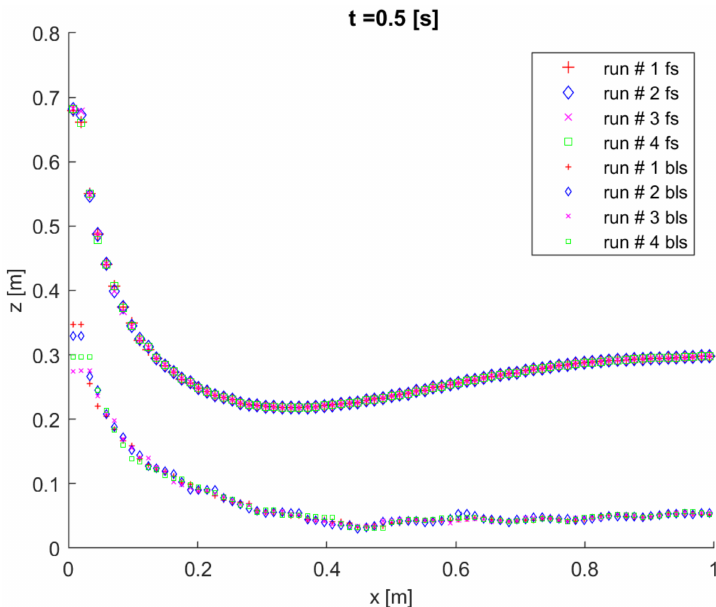
Figure 3. Comparison of free surface (fs) and mixture–water interface (bls) at the reference time t = 0.5 s. Threshold viscosity increases from Run 1 to Run 4 according to Table 1.